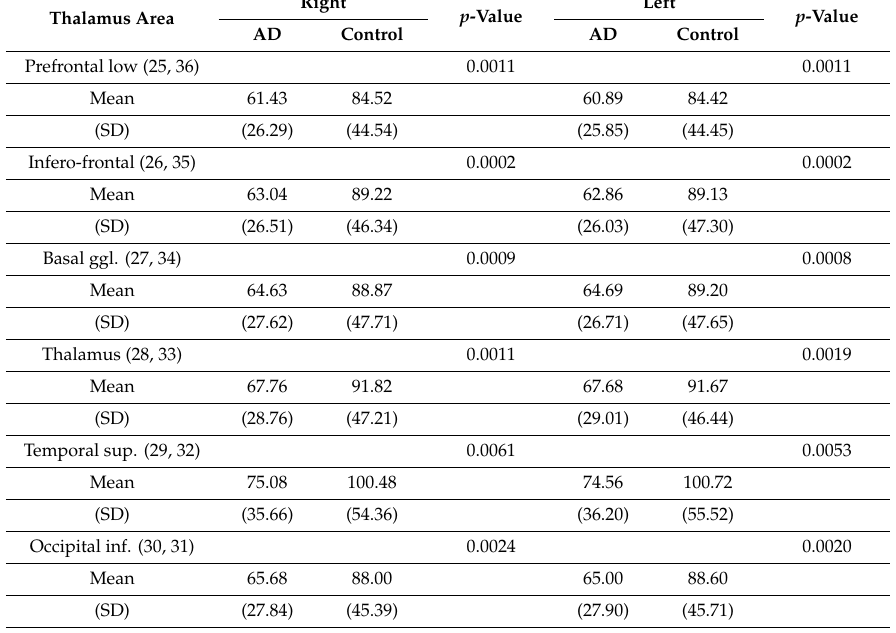
Table 3. Comparison count number thalamus area of the brain for AD patients and control group (mean and SD).